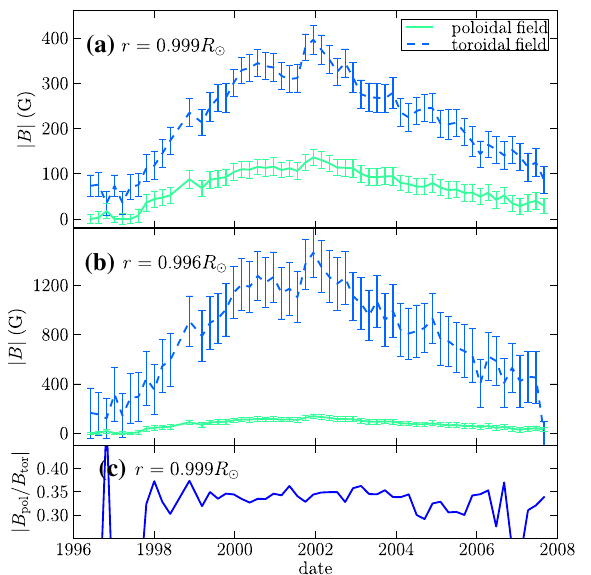
Fig. 31 Strength of the inferred magnetic fields plotted as a function of time for solar cycle 23. a , b The magnetic field strengths at 0 . 999 R (cid:6) and 0 . 996 R (cid:6) respectively. c The ratio of the poloidal to toroidal field at 0 . 999 R (cid:6) , the ratio looks similar at 0 . 996 R (cid:6) . Thus while the strength of both poloidal and toroidal fields change with time, their ratio does not evolve much. The results in this figure are from Baldner et al. (2009). (Image courtesy of Charles